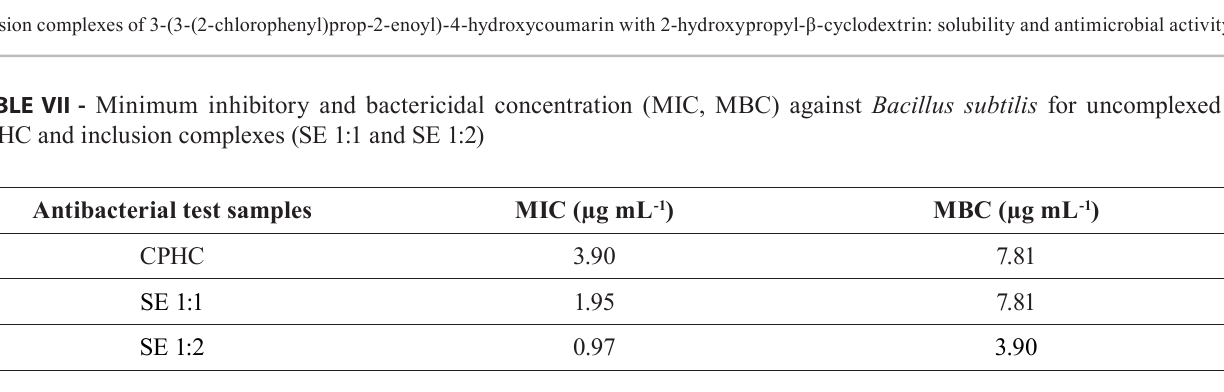
TABLE VIII - Minimum inhibitory and bactericidal concentration (MIC, MBC) against Staphylococcus aureus for uncomplexed CPHC and inclusion complexes (SE 1:1 and SE 1:2) Antibacterial test